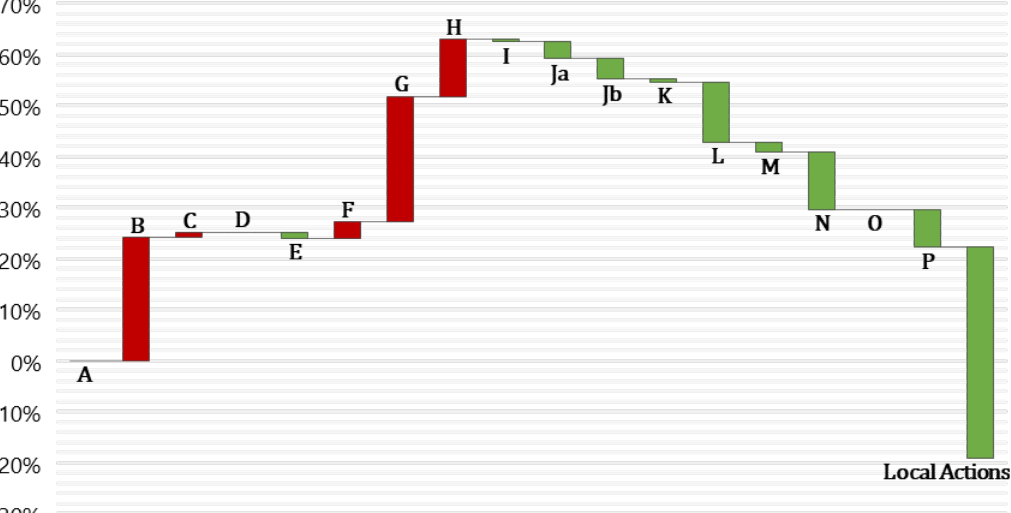
Figure 4. Disaggregation of the observed changes in local GHG emissions, between 1990 and 2015, per factor of change for the municipality of Malmö, as a percentage of the base year emissions level. (A—Climate; B—Population; C—Activeness; D—Urbanization; E—Household conditions; F—Transportation habits; G—Local economy; H—Private consumption; I—Energy Prices; Ja—Autonomous savings private consumers; Jb—Energy intensity economic sectors; K—Energy supply sector; L—Energy taxes; M—Building regulations; N—Transport regulations; O—Energy efficiency requirements; P—Other policies; Local Actions).